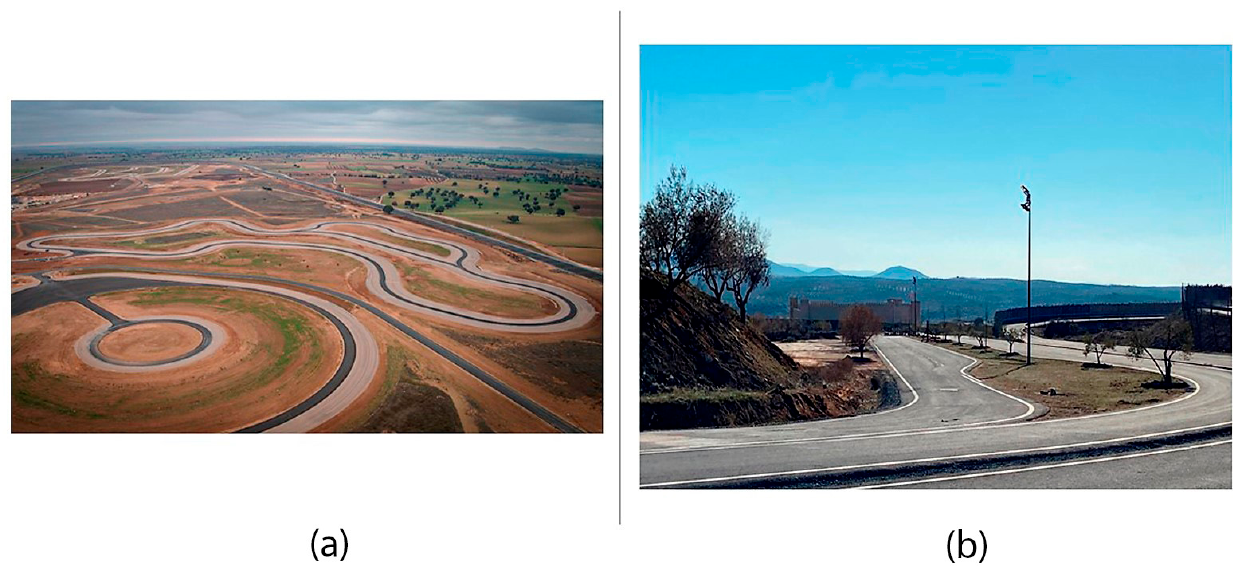
Figure 4. ( a ) Nokian Tyres circuit, left; ( b ) Puy du Fou España, right. Source: company management, used with permission, and author’s own photograph from April 2021. If interested, the reader can request further photos from the author by email at: luisalfonso.escudero@uclm.es.